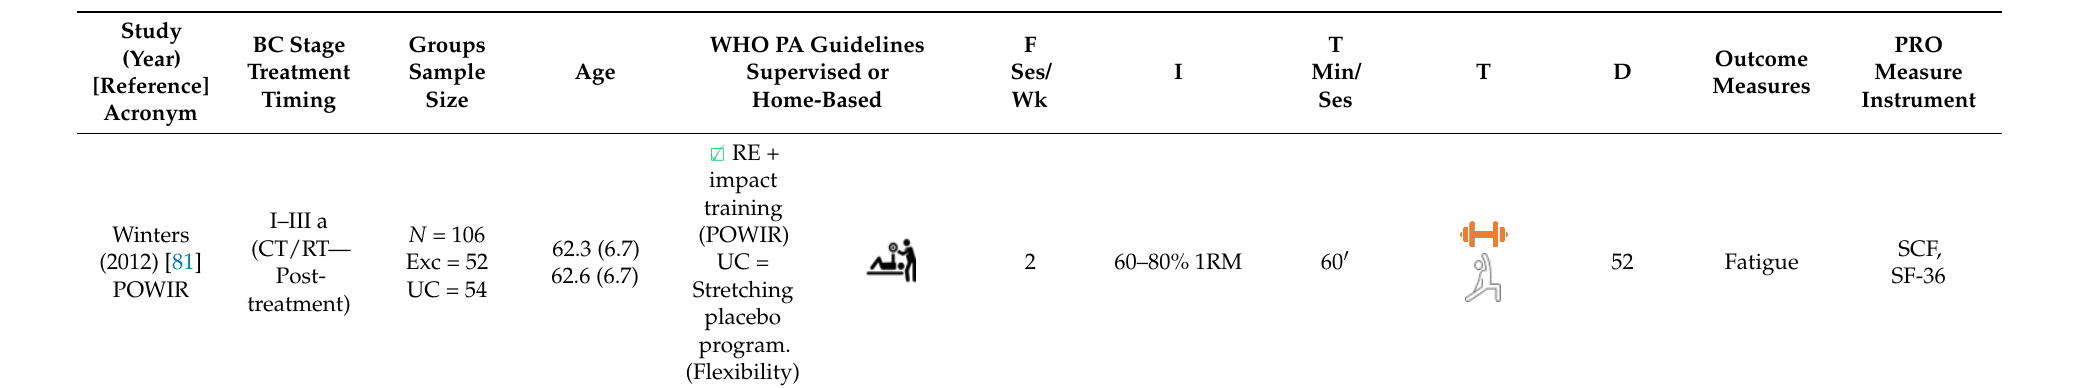
Table 2. Characteristics of the studies